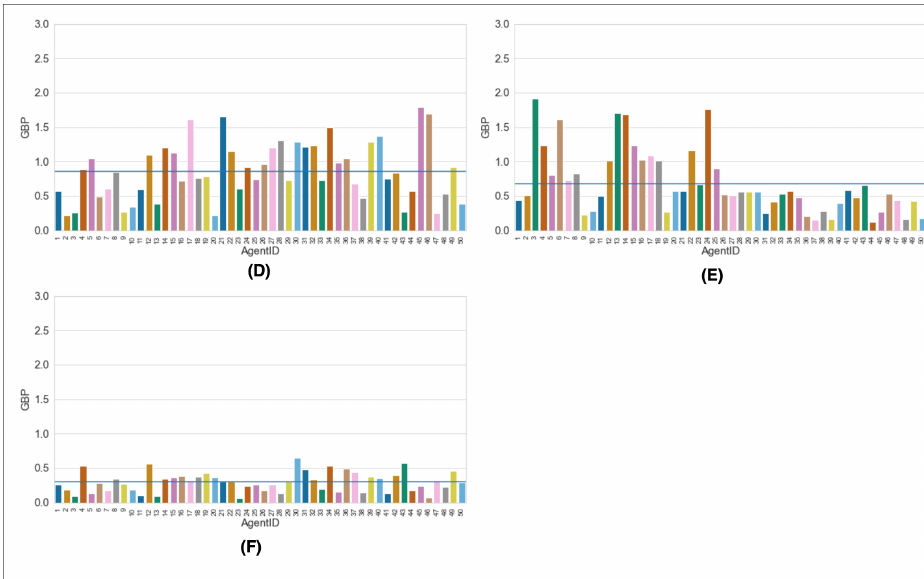
Figure A2. Thetotal sum of electric costs (GBP) for each PHEV, model conditions 4 to 6. Where ( D ):